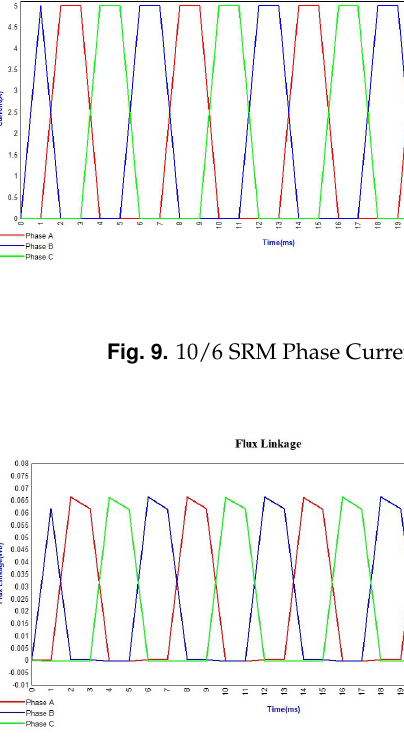
Fig. 10. 10/6 SRM flux